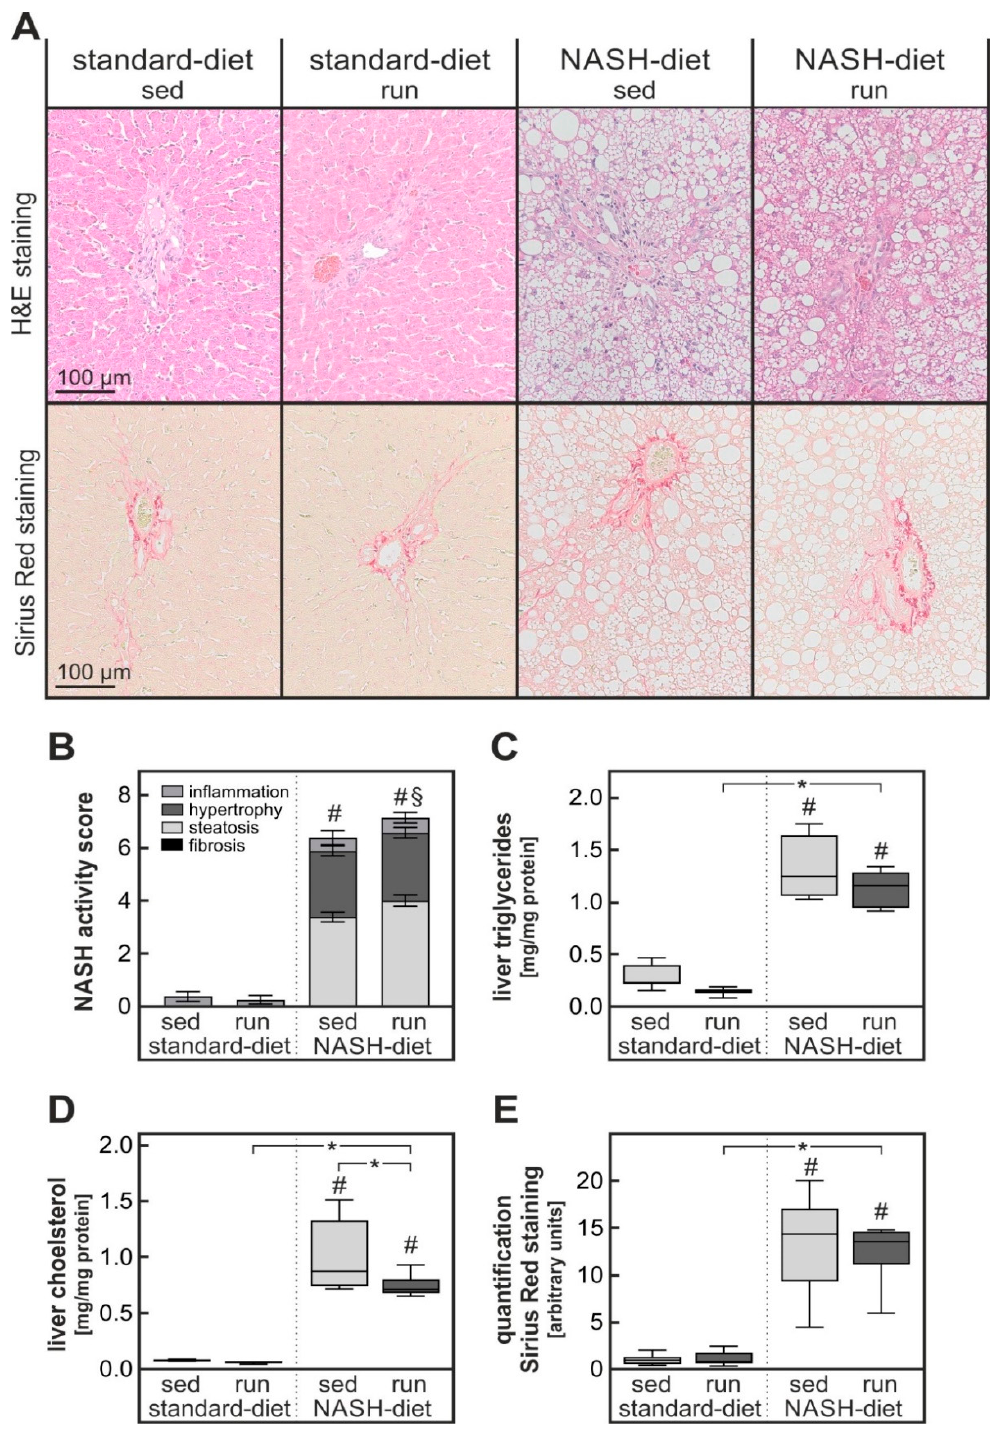
Figure 3. Impact of diet and exercise on liver histology, NASH activity score, fibrosis, and hepatic lipid accumulation. ( A ) Liver slices of the four intervention groups described in the legend to Figure 1 were stained with H & E or Sirius Red. Representative microphotographs, magnification 20×. ( B ) H&E-stained liver slices were scored according to a NASH activity score adapted for rodents [14] by a liver pathologist blinded to the treatment group. ( C , D ) Liver triglycerides ( C ) and cholesterol ( D ) were determined by enzymatic assays in liver homogenates. ( E ) The Sirius Red staining intensity was quantified densitometrically in parenchymal areas of the liver slices. Values are mean ± SEM (B) or median (line), upper and lower quartile (box) and extremes (whiskers) ( C – E ). Statistics: ( B ) Kruskal-Wallis test with Dunn’s post hoc test for multiple comparisons; ( C – E ) Two-way-ANOVA with Tukey’s post hoc test for multiple comparisons; #: significant versus sedentary standard-diet group, §: significant versus exercised standard-diet group, * p < 0.05 between compared groups.